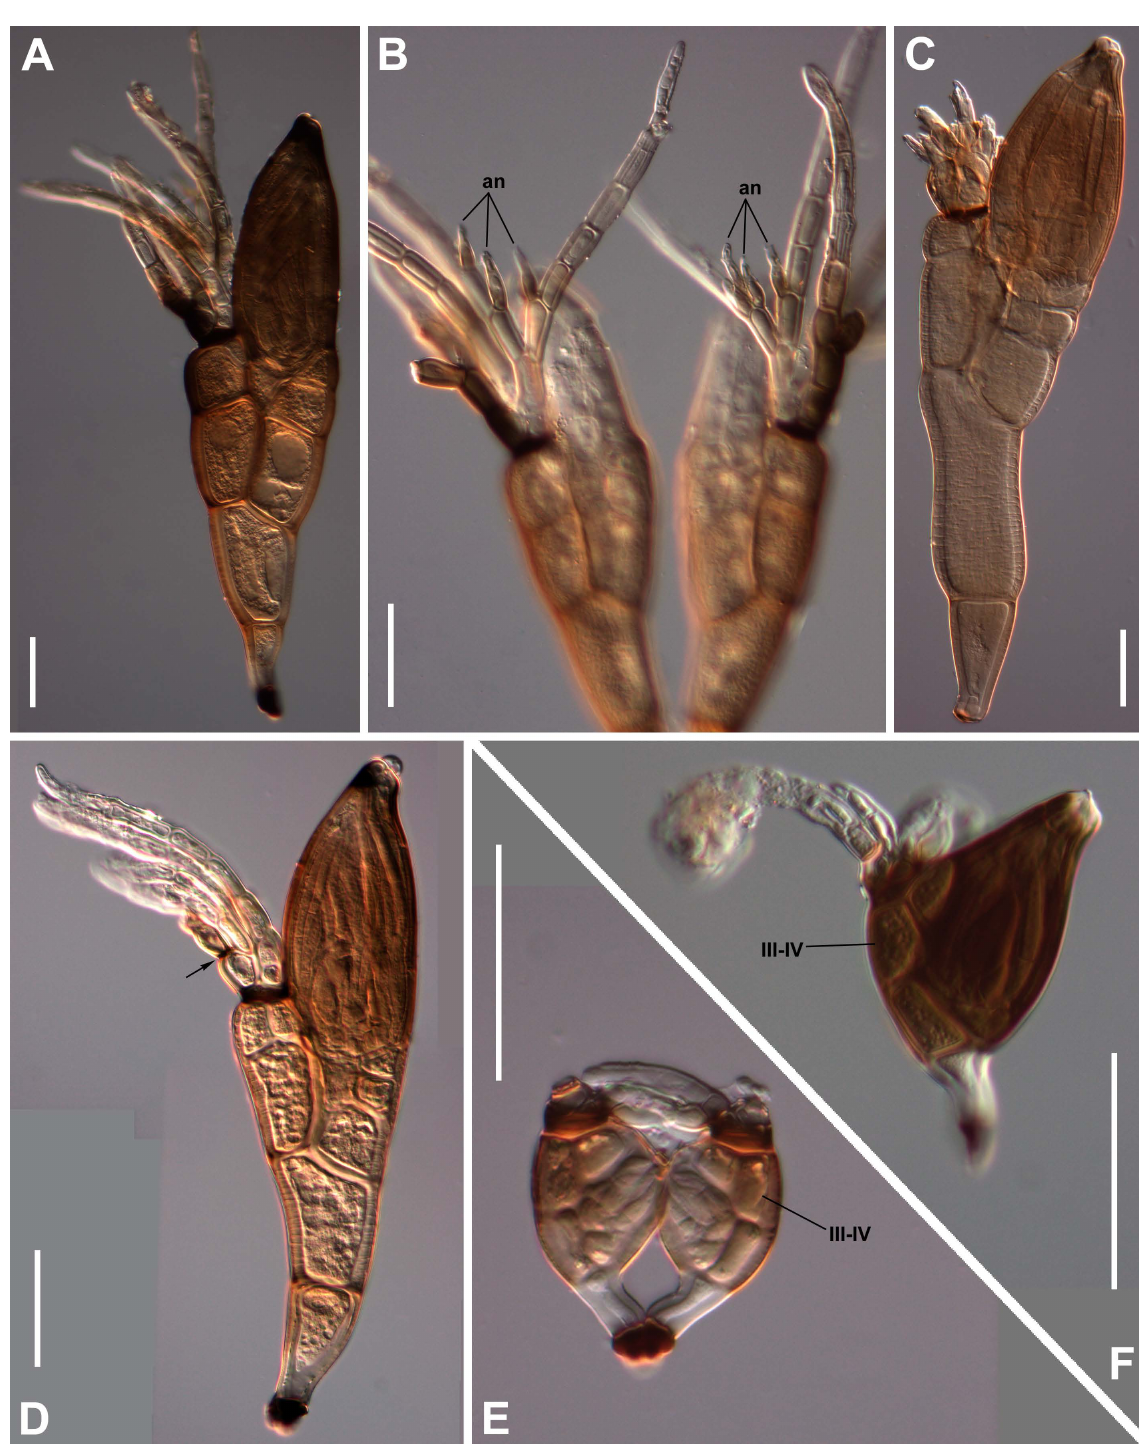
Fig. 43. Laboulbenia spp. A – B . L. rougetii Mont. & C.P.Robin. A . Mature thallus. B . Two young thalli showing antheridia (an). – C – D . L. slackensis Cépède & F.Picard. In D, the black and constricted septum separating the basal cell of outer appendage from outermost branch is labelled (arrow). – E – F . L. sphaerii Santam. E . A pair of two immature thalli. F . Mature thallus from holotype. Both images with undivided cells III and IV being labelled. Scale bars: 50 µm. Photographs from slides ZMUC C-F-124117 (A–B), ZMUC C-F-124219 (C), ZMUC C-F-122634 (D), ZMUC C-F-124098 (E), BCB SS1047b (holotype)